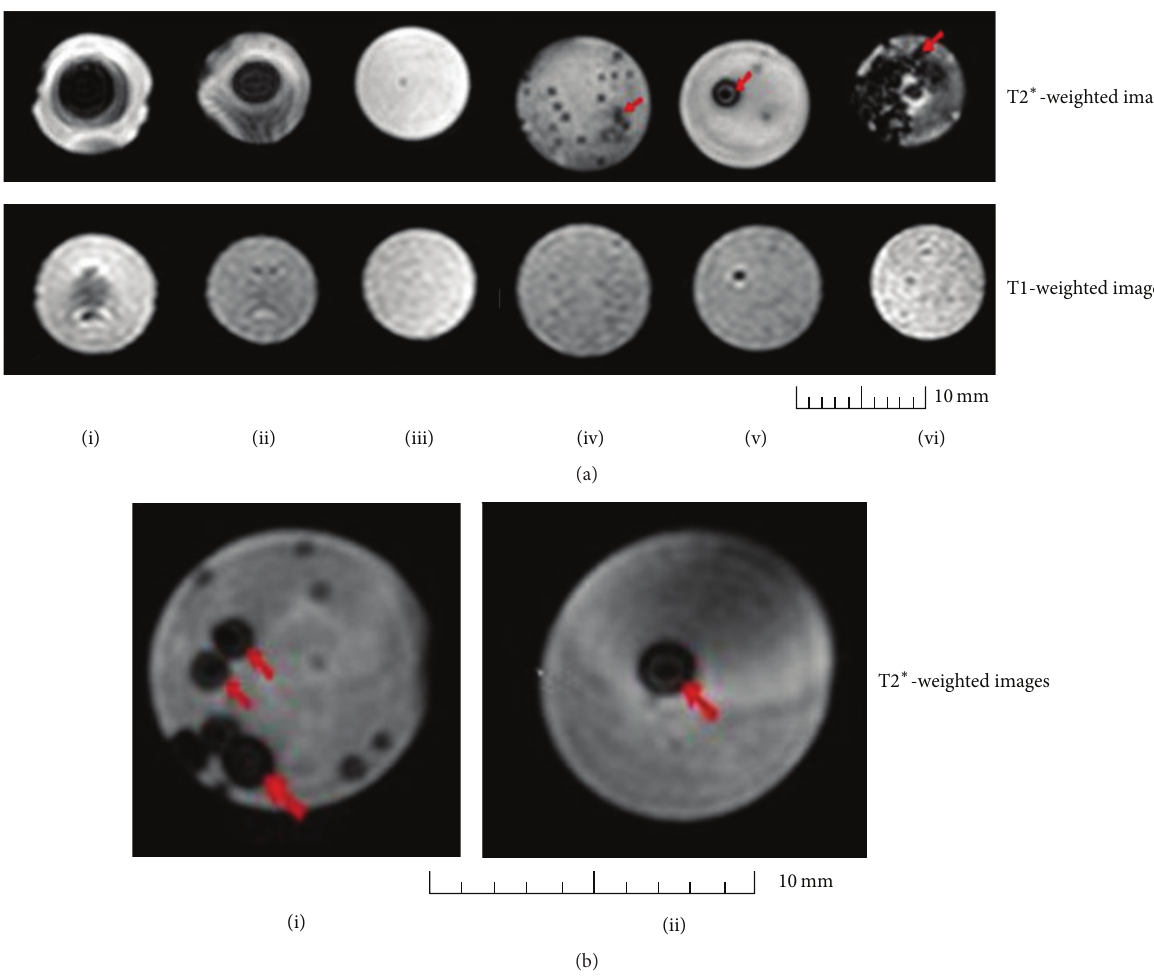
Figure 5: In vitro MRI of encapsulated MM-labelled cells by 3 T scanner. (a) T 2 ∗ - and T1-weighted images of 3 𝜇 L (i) and 1 𝜇 L (ii) of naked MM solution; encapsulated unlabelled MIN6 (iii); encapsulated MM alone (iv); single capsule of encapsulated MM-labelled MIN6 (v); and clusters of encapsulated MM-labelled MIN6 (vi). (b) T 2 ∗ -weighted images of clusters (i) and single capsule (ii) of encapsulated MM-labelled human islets. The red arrows point to the discrete hypointense spots created on the agarose phantoms by MM.